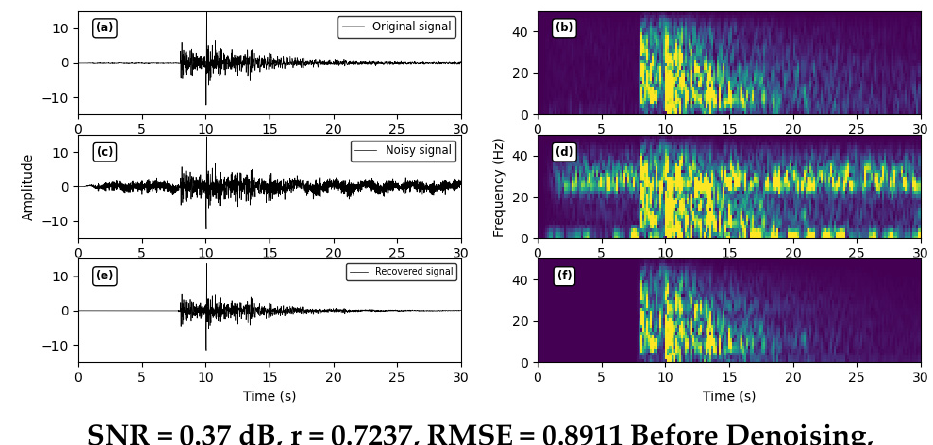
Figure 10. Co-band denoising of band-limited noise and seismic signals.